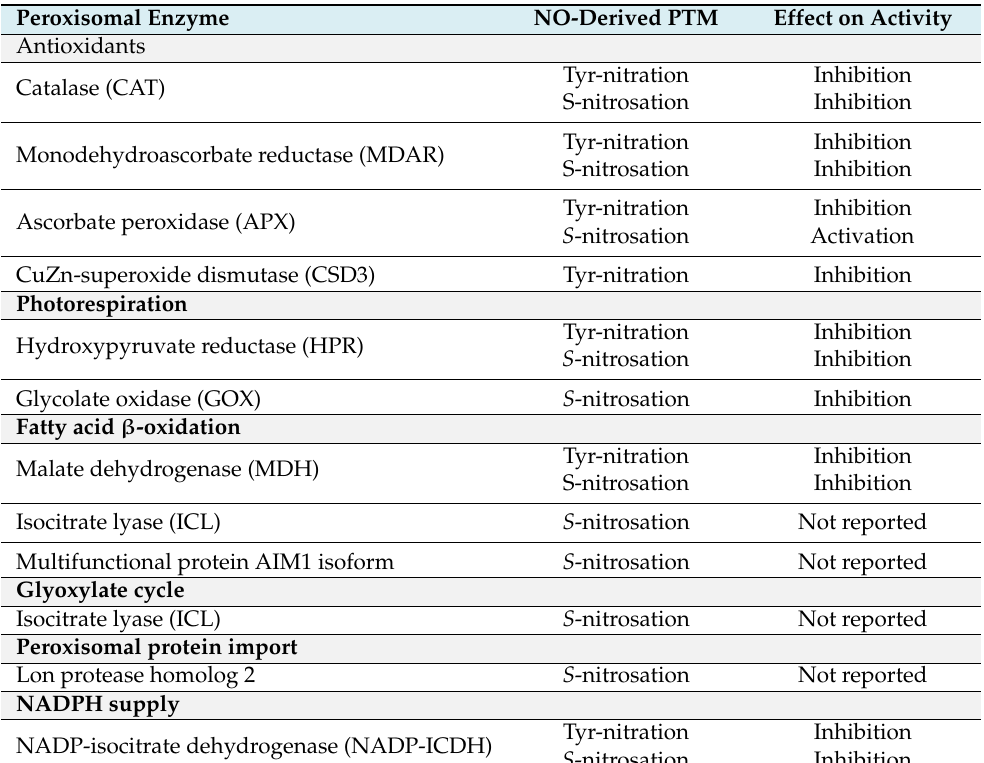
Table 2. Identified peroxisomal enzymes target of diverse NO-derived posttranslational modifications (tyrosine nitration or S -nitrosation) and the effect on their function. Peroxisomal Enzyme NO-Derived PTM Effect on Activity